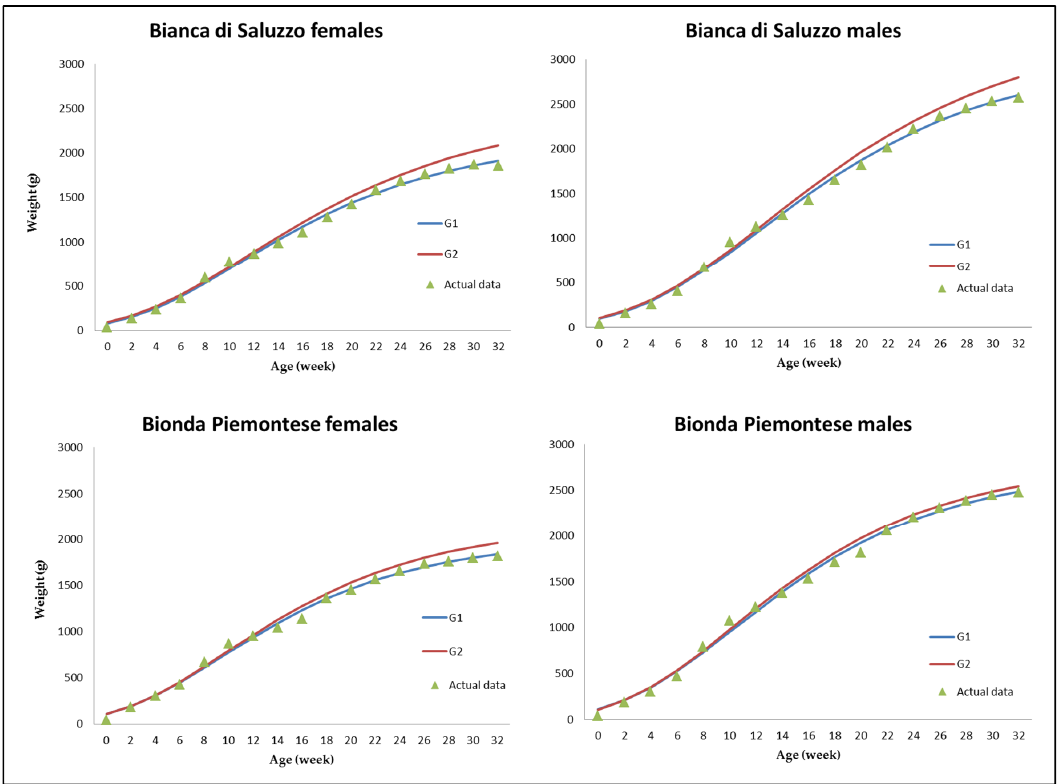
Figure 1. Predicted weight at different age for the Bianca di Saluzzo and Bionda Piemontese chicken breeds according to the Gompertz (G) model. Blue line, G1 model; red line, G2 model; triangle, actual data.